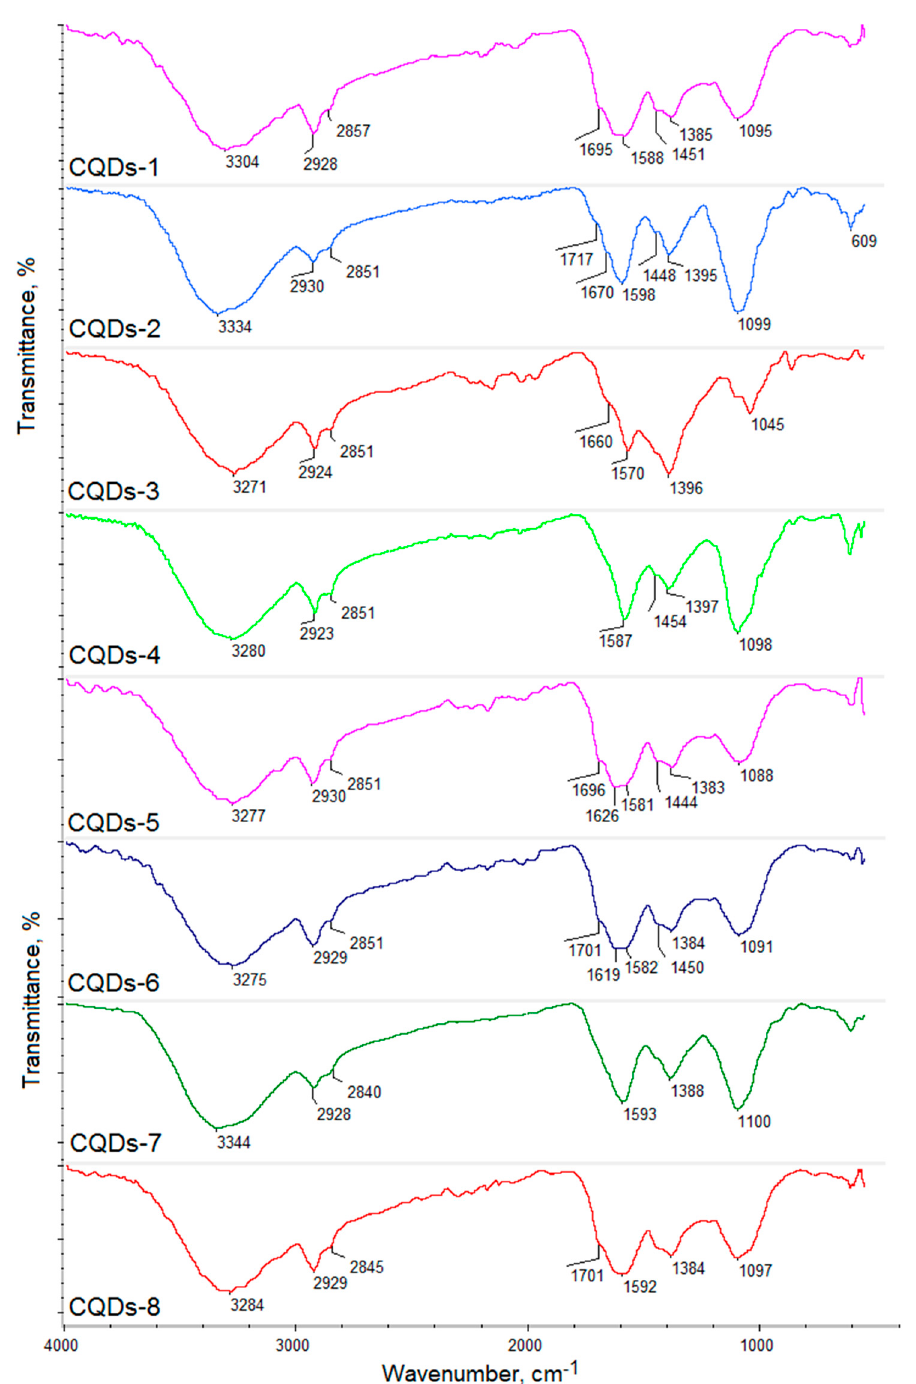
Figure 3. FT-IR spectra of the prepared samples.